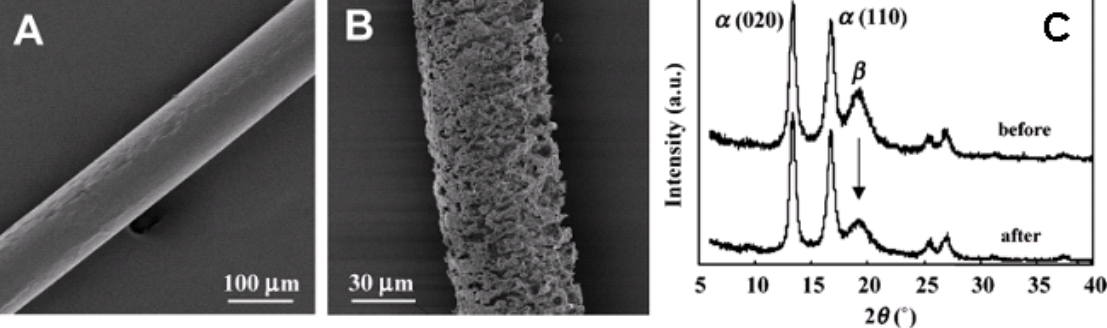
Figure 13. Partial enzymatic degradation of PHA fibers. SEM of drawn annealed P(3HB) fibers before (A) and after partial enzymatic degradation by R . pickettii T1 (B). (C) Intensity profiles of equatorial lines in X-ray fiber diagrams before and after partial enzymatic degradation by PHA depolymerase purified from R . pickettii T1 at 37 °C. The α and β indicate the reflections derived from α -form and β -form crystal, respectively [83].